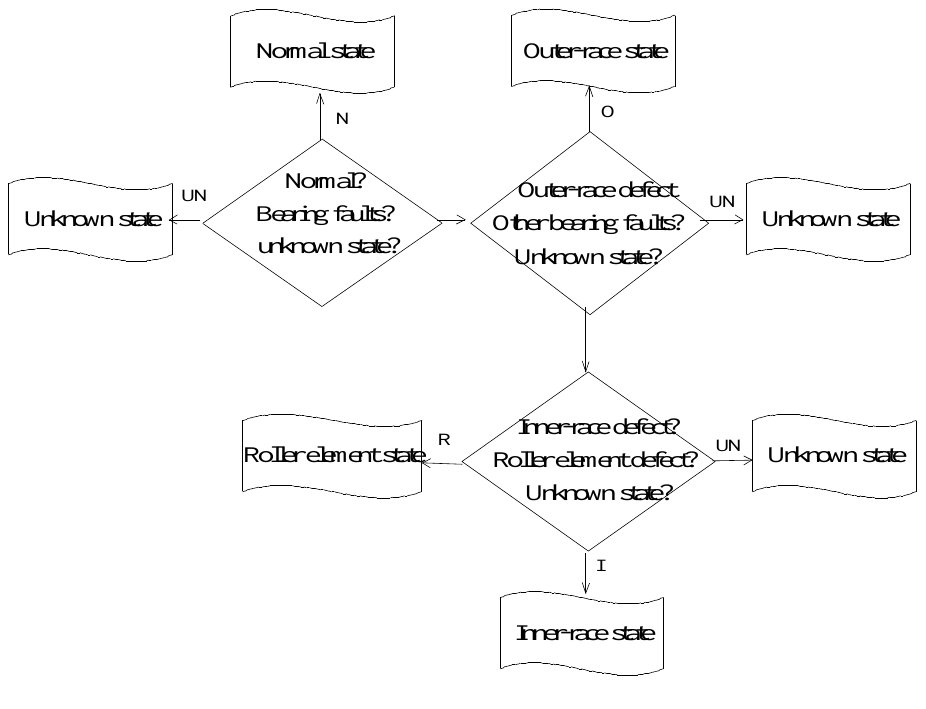
Figure 7. Flowchart of the sequential condition diagnosis.